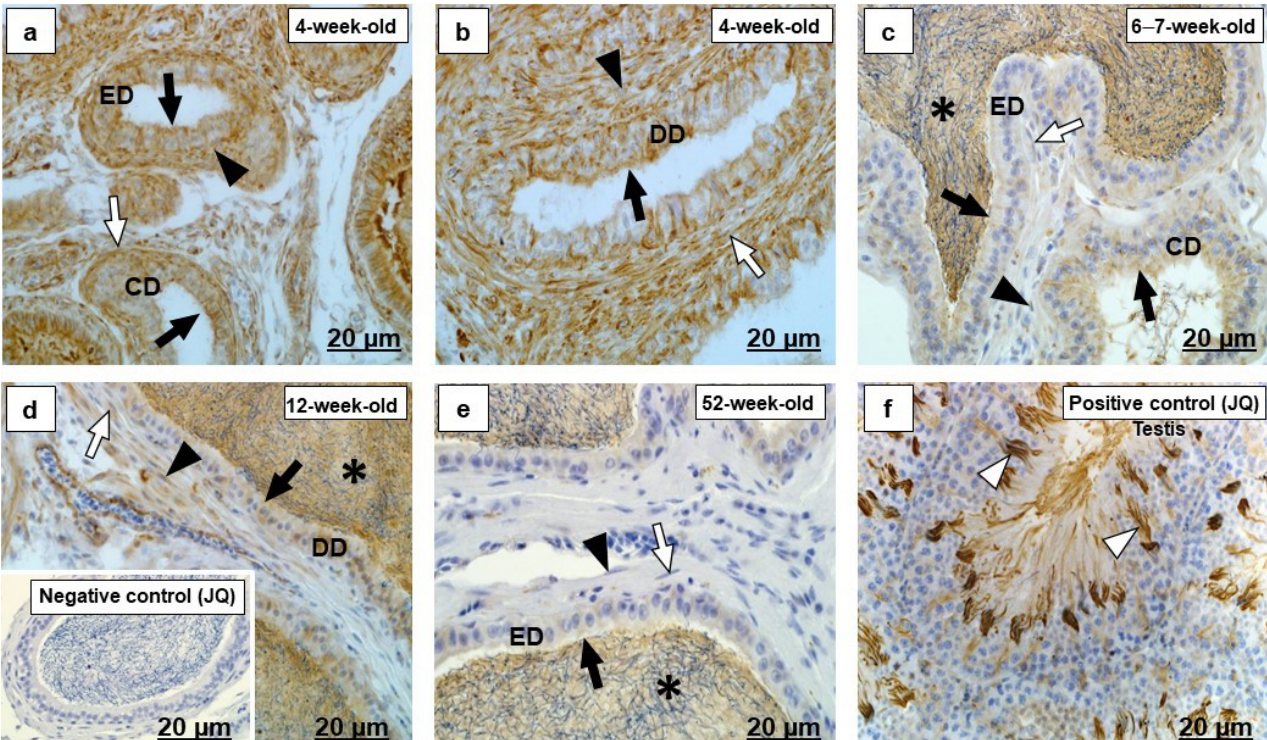
Figure 7. Immunolocalization of beta-tubulin in the epididymal duct unit- (CD) connecting duct, (ED) epididymal (DD) duct and ductus deferens of the testicular excurrent duct system of Japanese quails ( n = 7 per age group). ( a , b ) Strong immunostaining in the epithelia (black arrows) of the CD, ED and DD. Moderate to strong immunostaining in the periductal smooth muscle cells (white arrows) and fibroblasts (black arrowheads). ( c , d ) Moderate to weak immunostaining in the epithelia (black arrows) of the CD, ED and DD. Moderate to weak immunostaining in the periductal smooth muscle cells (white arrows) and fibroblasts (black arrowheads). ( e ) Weak immunostaining in the ED epithelium (black arrow). Immunonegative periductal smooth muscle cell (white arrowhead) and fibroblast (black arrowhead). ( c – e ) Asterisks depict immunostaining of the luminal spermatozoa. Inset ( d ) Negative control: Epididymal duct of an adult Japanese quail. ( f ) Positive control: Immunopositive sperm (white arrowheads) in the testis of an adult Japanese quail. JQ, Japanese